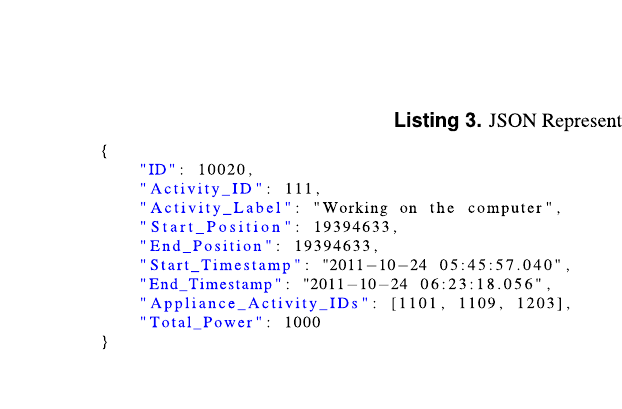
Table 3. List of RIFF metadata chunks supported by